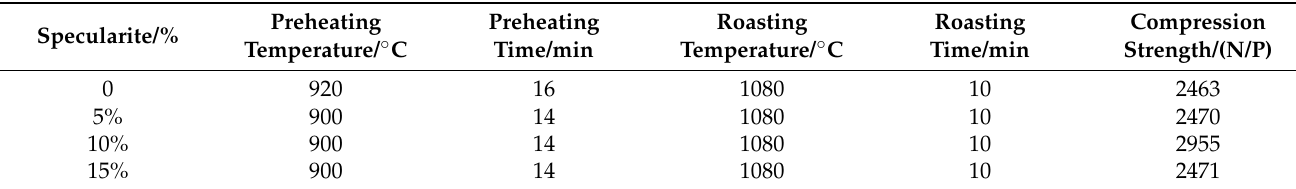
Table 4. Effect of specularite content on compression strength of